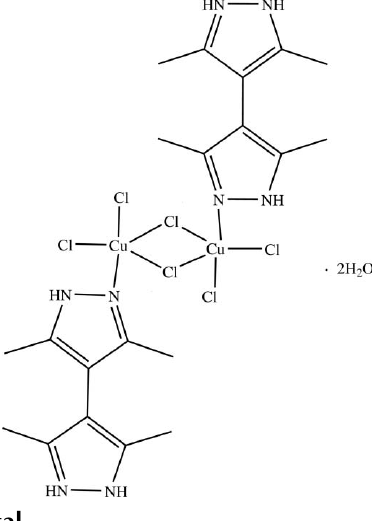
The structure of the centrosymmetric title compound,